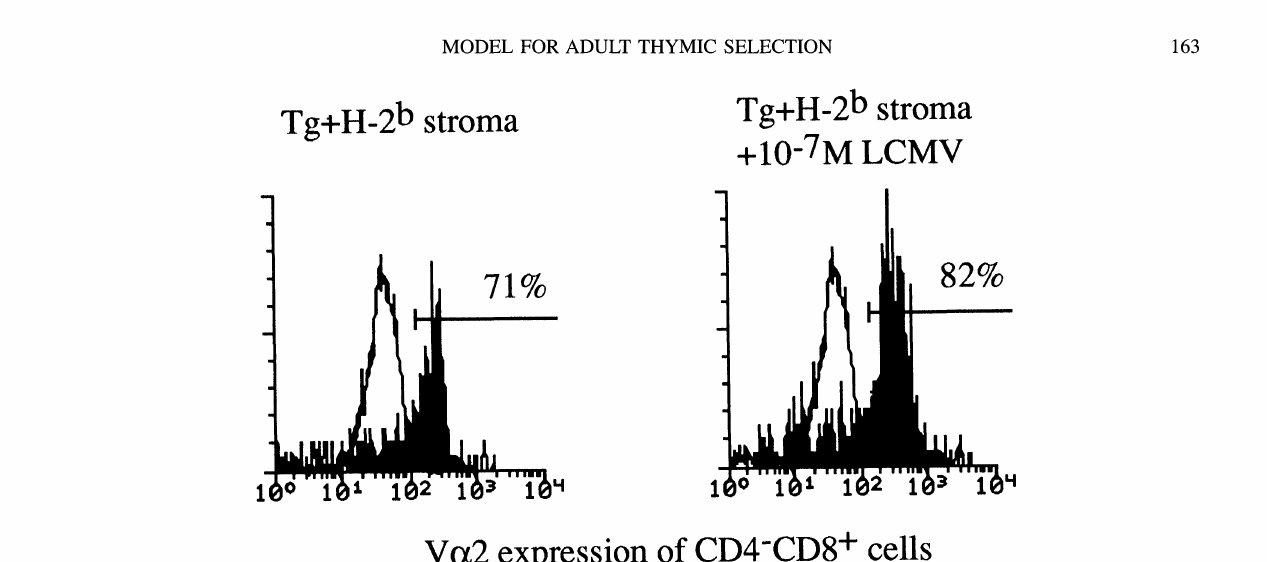
FIGURE 4 CD4-CD8 positively selected transgenic cells have upregulated the TCR. Histograms show Va2 expression of preculture El7 (H-2 d) transgenic CD4-CD8 cells (solid line) and postcoculture CD4-CD8 cells (shaded histogram). Transgenic cells (H-2d; El7) were cocultured with H-2 stroma (Ly 5.1; C57B16) in the absence or presence of nominal LCMV peptide at a concentration of 10 -7 M, for 5 days. Cells were harvested and analyzed by FACS. Transgenic cells were distinguished by Ly 5.2